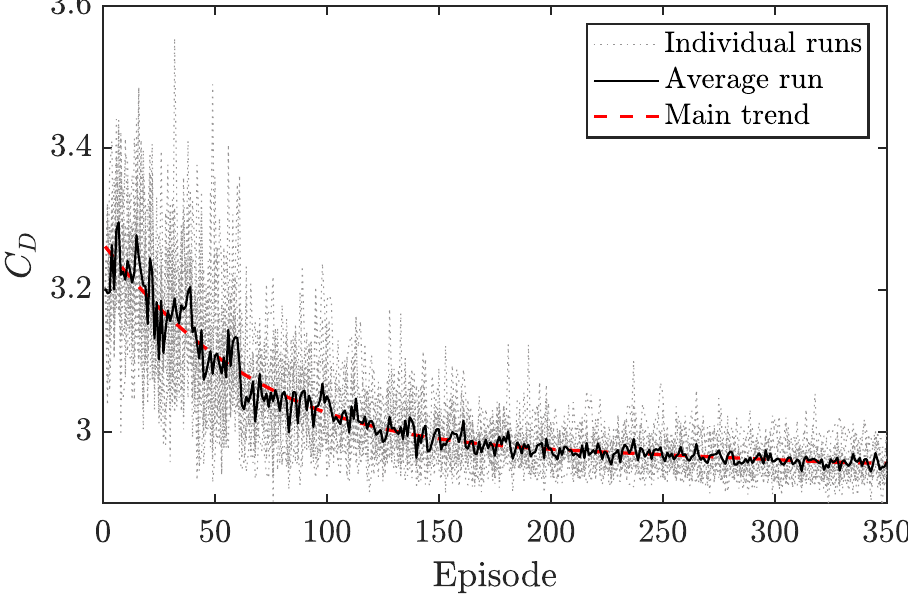
Figure 7. Evolution of C D in the last vortex-shedding period as a function of the